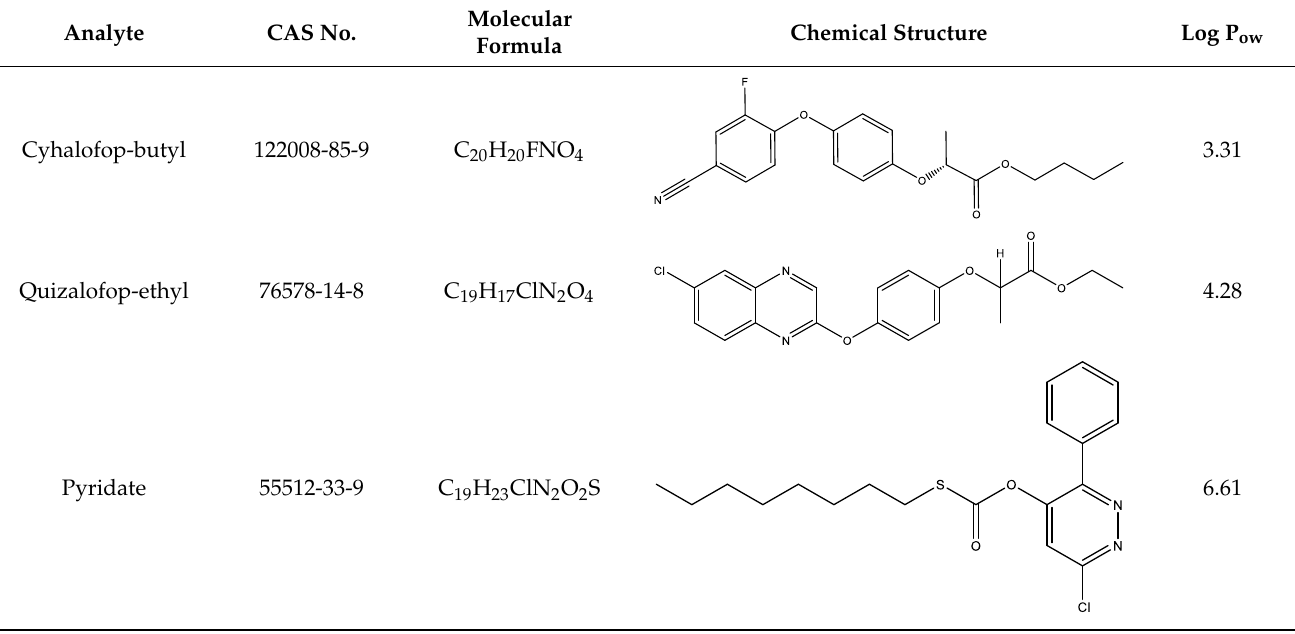
Table 1. Physicochemical characteristics of pyridate, cyhalofop-butyl, and